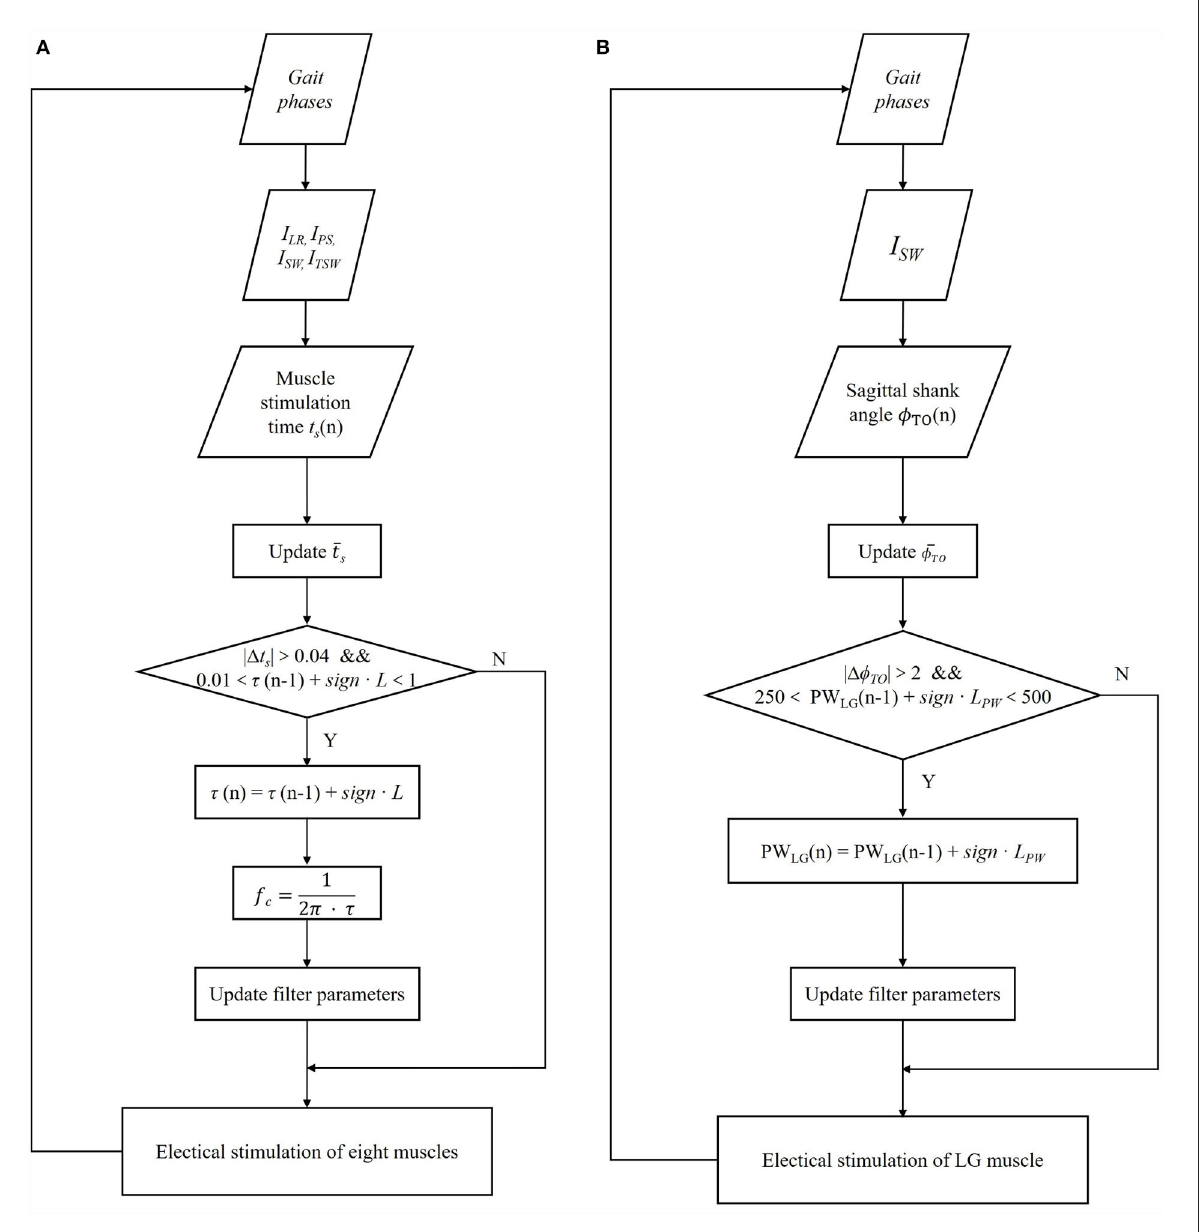
FIGURE4 Block diagram of the iterative learning control algorithm for transfer function time constant coefficient τ of all eight muscles (A) and pulse width parameter of two lateral gastrocnemius muscles (LG) (B) based on each gait cycle.